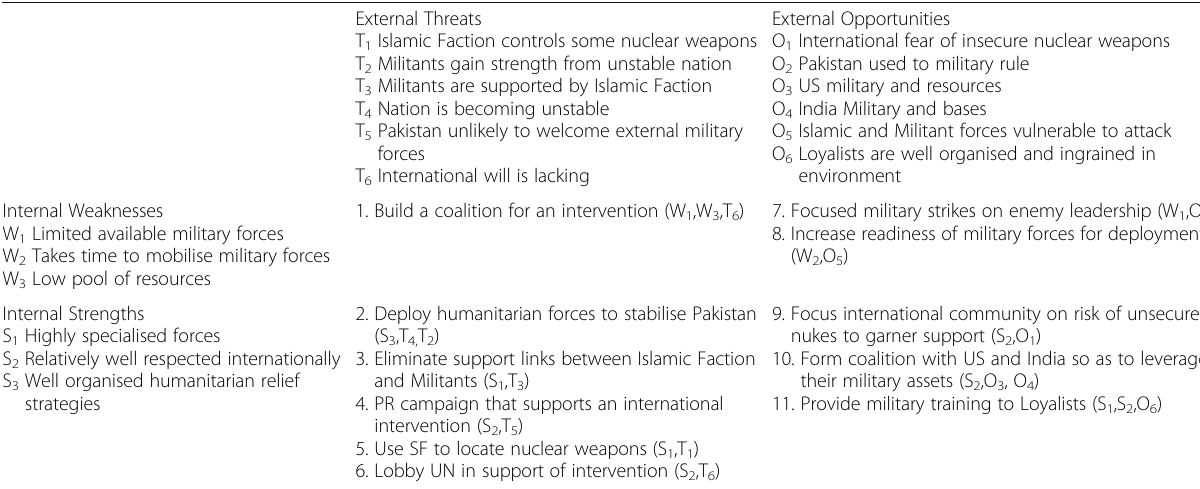
Table 4 TOWS part 2 — creating a number of feasible actions by combining external with internal factors. Actions also show the internal and external factors they are sourced from